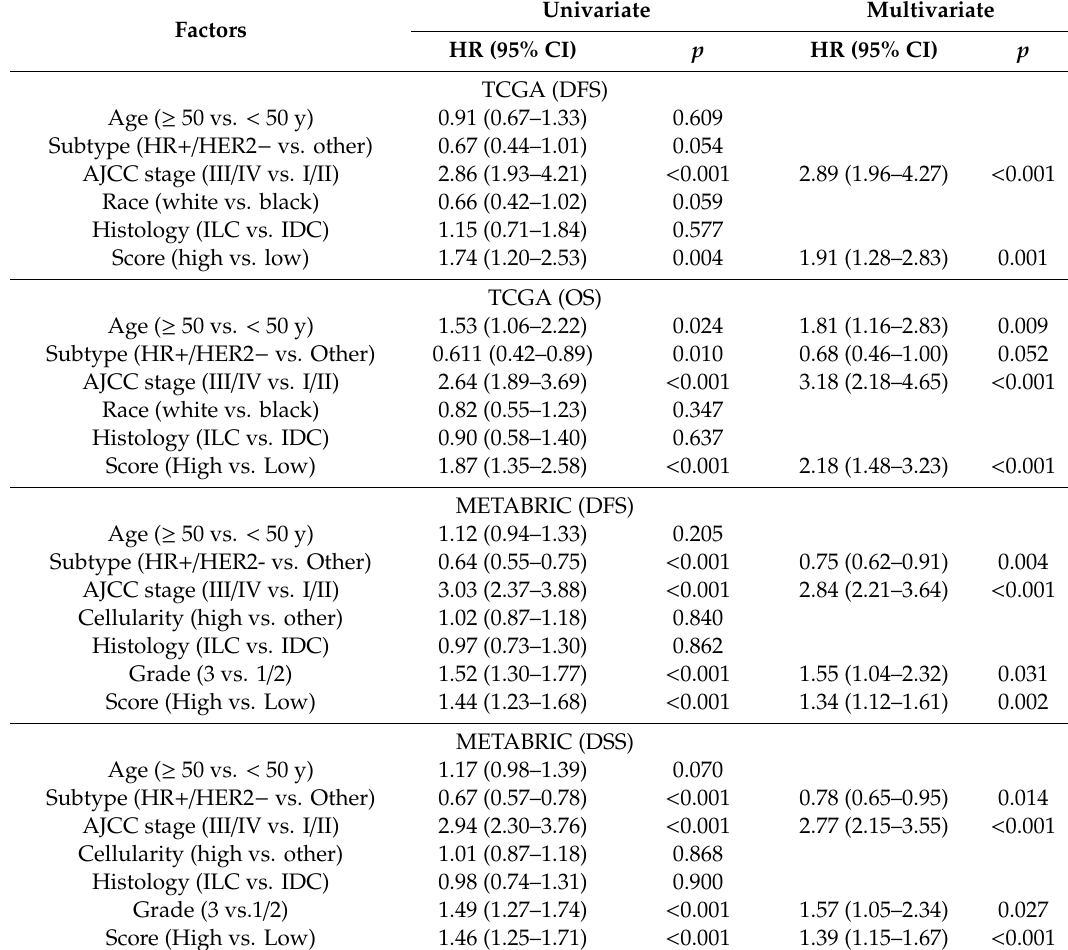
Table 1. Survival analyses of 4-gene score and other factors in TCGA and METABRIC cohorts.